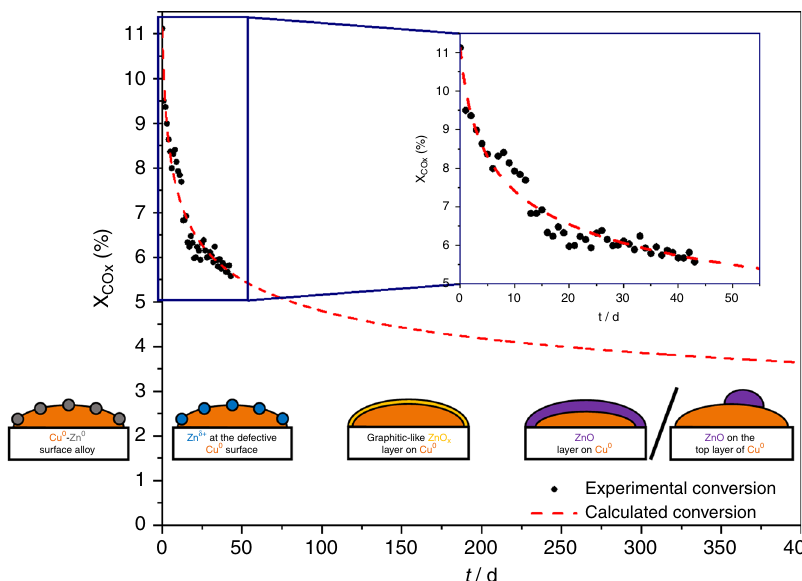
Fig. 4 Long-term methanol synthesis over the industrial Cu/ZnO/Al 2 O 3 catalyst at 210 °C and 60 bar. Recorded degrees of conversion (black points) under differential controlled conditions. The dashed red curve describes the intra- and extrapolation of the experimental data, which was calculated with the MATLAB ® software according to the studies of Fichtl et al. 18 . Illustrations from right to left: Cu 0 – Zn 0 surface alloy according to Nakamura et al. 11 . Zn δ + species at the defective Cu 0 surface according to Behrens et al. 13 , graphitic-like ZnO x layer on Cu 0 according to Lunkenbein et al. 14 . ZnO layer on Cu 0 according to Lunkenbein et al. 23 as well as Fichtl et al. 18 and ZnO on the top layer of Cu 0 according to Kattel et al. 15